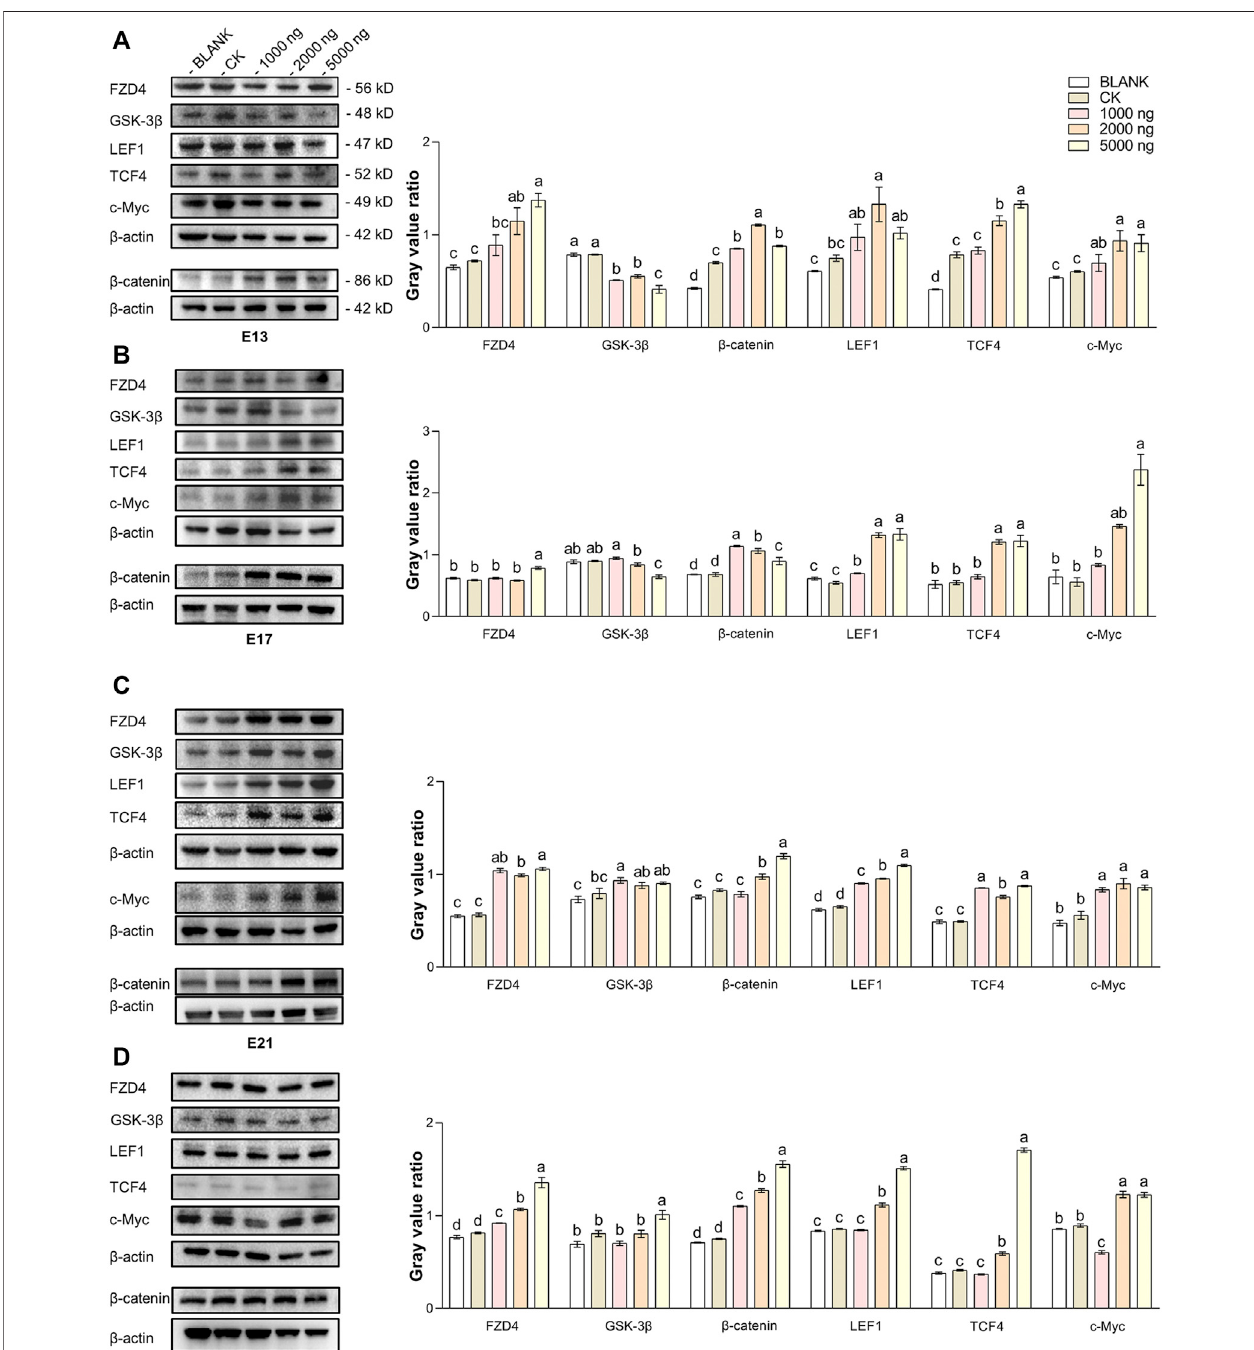
FIGURE5| Inovo injection ofCHIR-99021 ingoose embryos activatestheWntsignaling pathway byinhibiting GSK-3 β .The expression ofFZD4, β -catenin, LEF1, TCF4, and c-Myc in dorsal tissues of each group at E13 (A) , E17 (B) , E21 (C), and E25 (D) , as detected by western blotting. All data are shown as mean ± SEM, no common superscript letter within the same embryonic day means statistical difference ( p < 0.05) byone-way ANOVA with Duncan ’ smultiple-range test. n = 6 embryos.